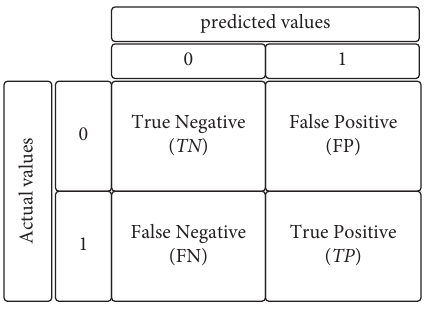
Figure 6: Confusion matrix for binary